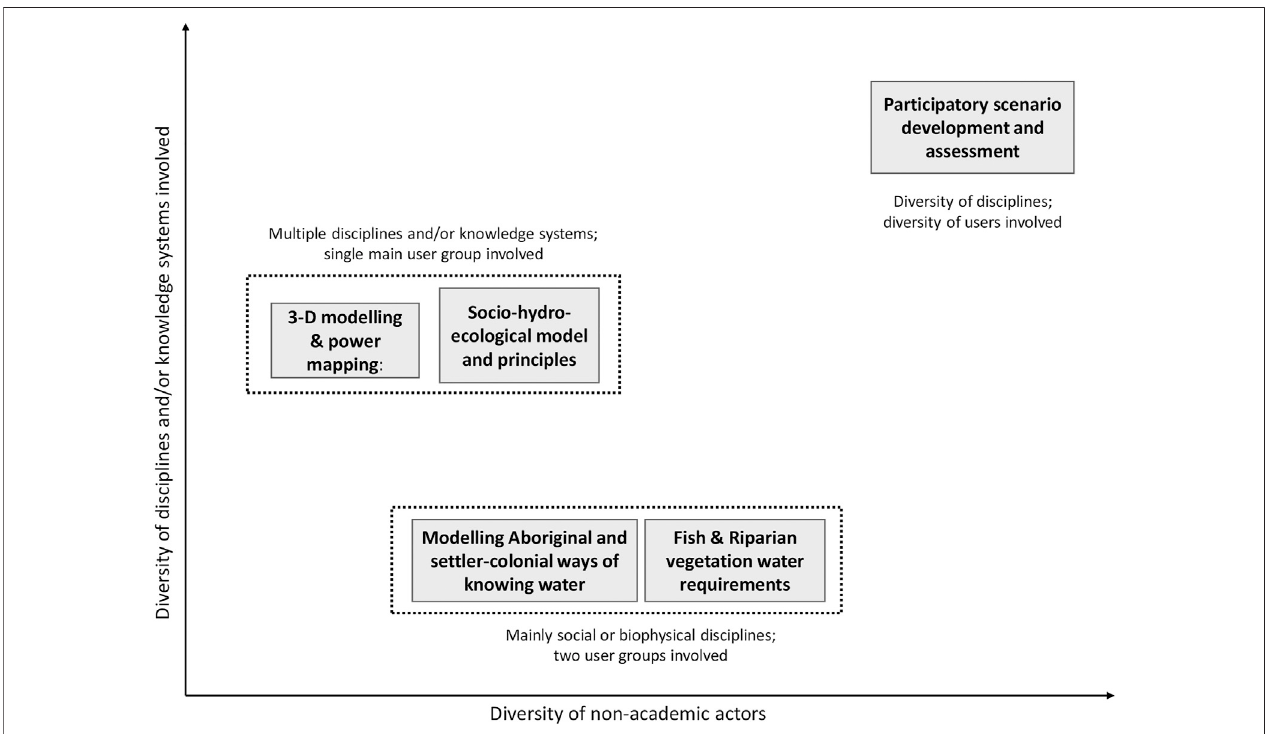
FIGURE 2 | Examples of TDR projects operating in the Fitzroy River catchment in the Kimberley region of Western Australia. Lower TDR projects are situated towards the lower-left area of the graph, while higher TDR projects are towards the upper-right area. The dotted box includes projects at the same level of TDR.